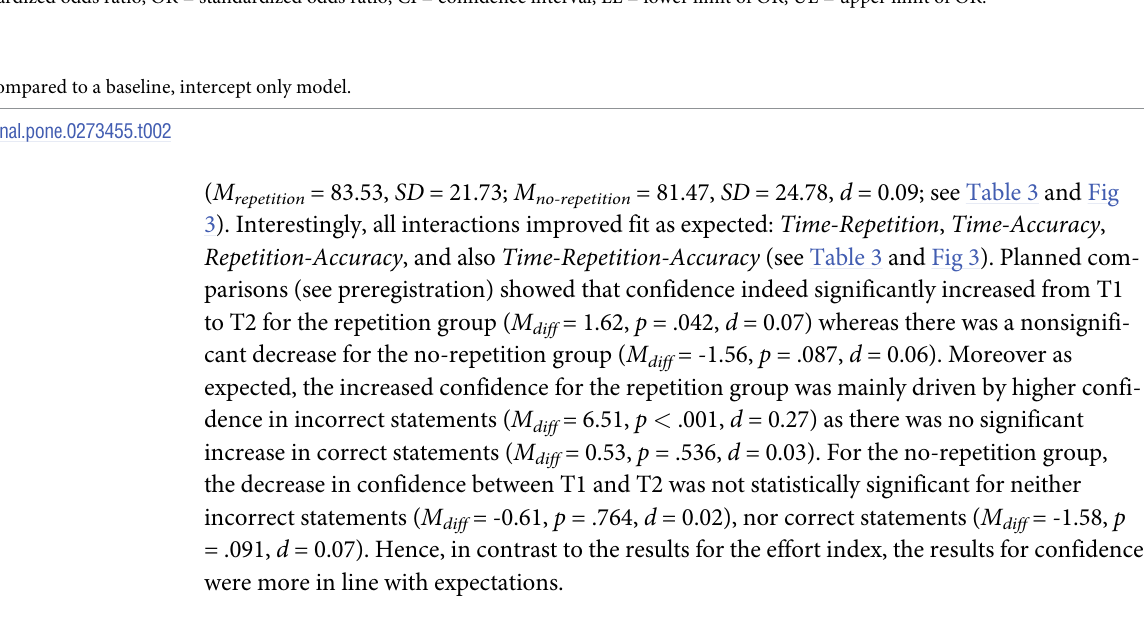
Table 2. Multilevel logistic regression analysis predicting memory accuracy from retrieval-effort cues and confidence (z-transformed). Predictor Hedges